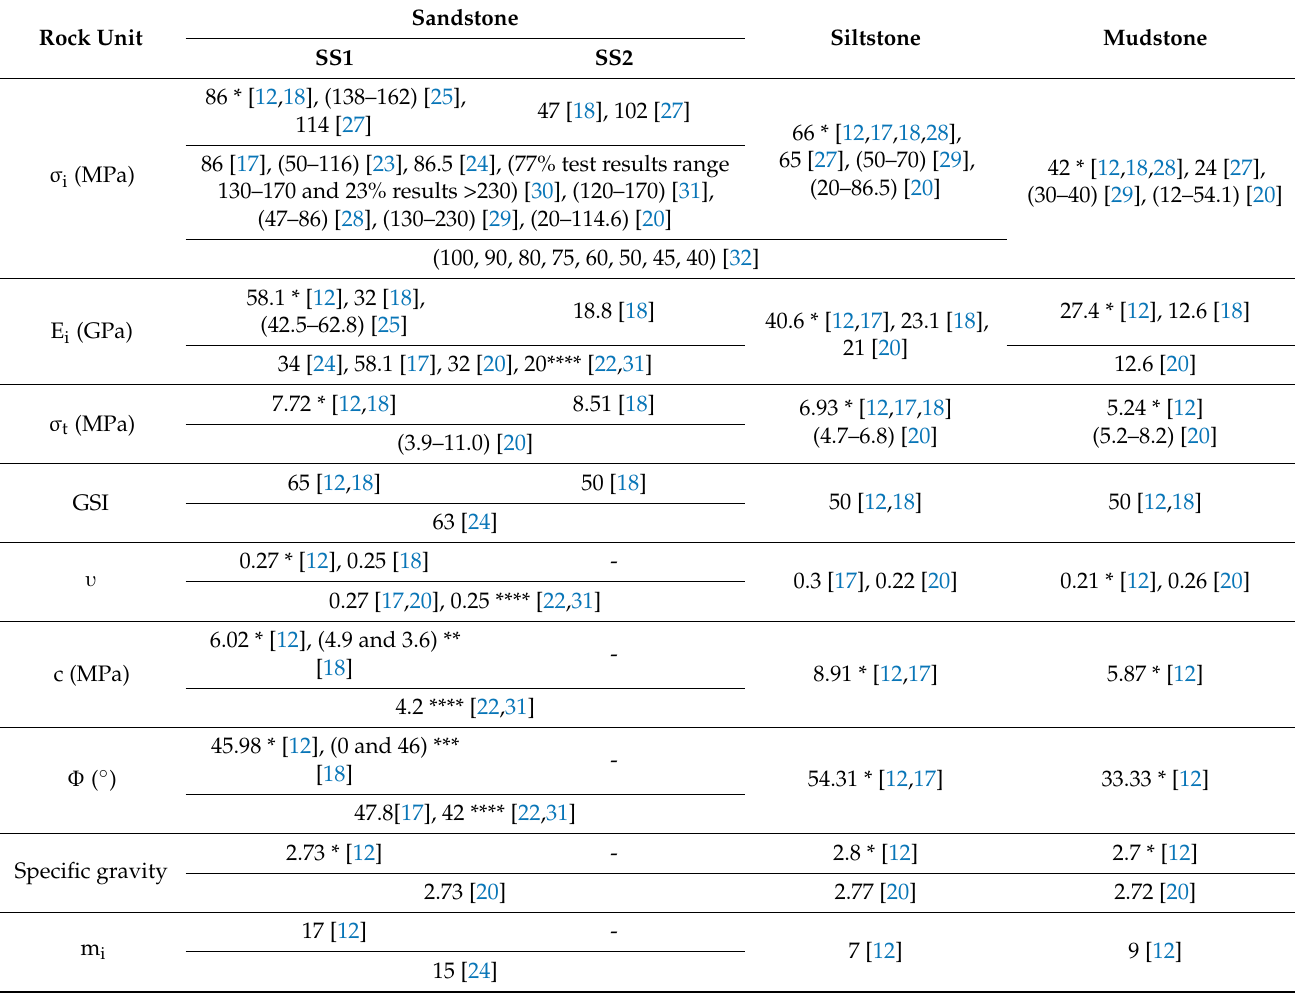
Table 2. Properties of rocks in the project